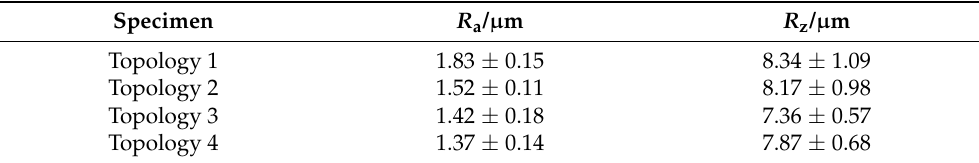
Table 4. Roughness results for specimens before crack propagation measurement.